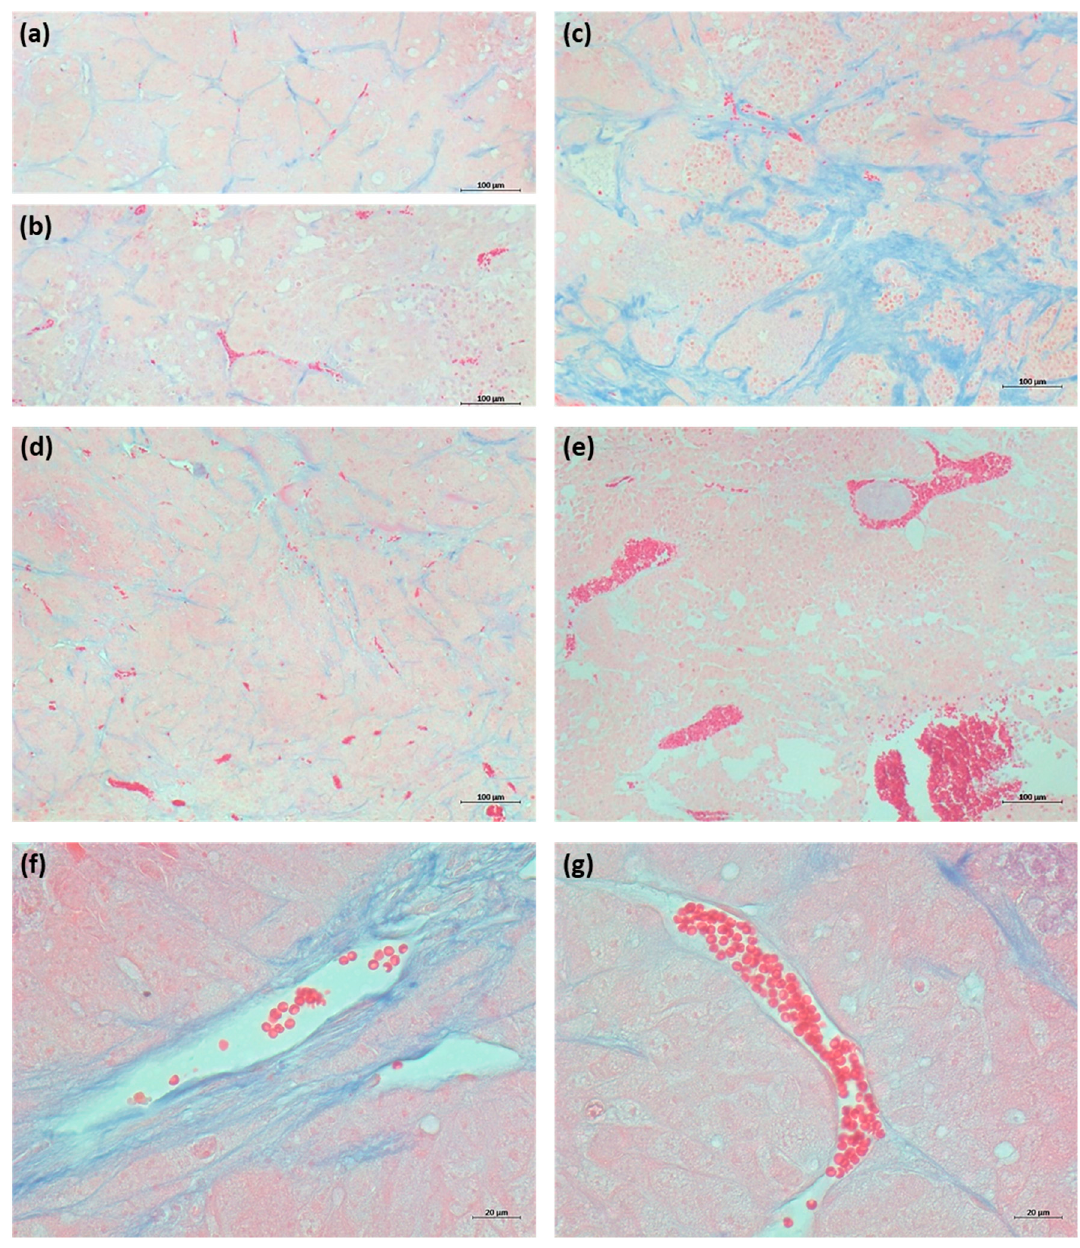
Figure 3. Analysis of tumor substructure after Azan staining. ( a – c ) Different areas of HT29 tumors, showing small vessels or capillaries embedded in collagen-rich septal structures or compositions with abundant fibrotic tissue. ( d ) DLD1 tumor showing similar structure to HT29 tumors. ( e ) 1411HP tumor showing large vessels and less extracellular material or stromal structures. ( f , g ) Examples of vessels of DLD-1 tumor, representing typical vessel structures found in DLD-1/HT29 tumors, showing distinct vessels with abundant ( f ) or normal ( g ) collagen-based supporting structure. (Scale bars: ( a – e )—100 µm; ( f , g )—20 µm).